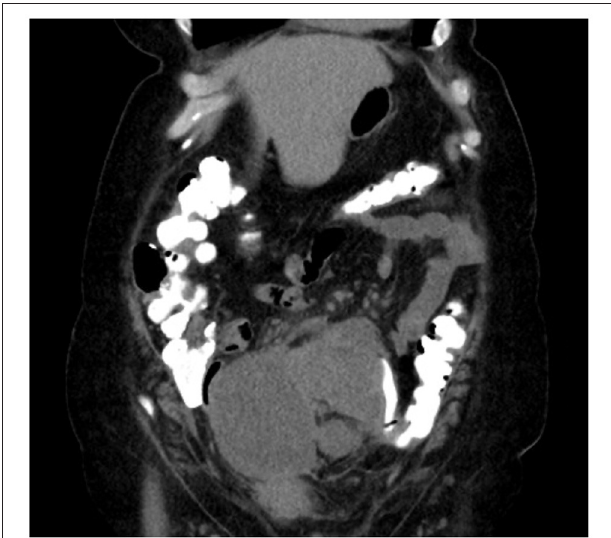
FIGURE 3 | Coronal CT with mass measuring ∼ 12.5cm × 8.5cm.